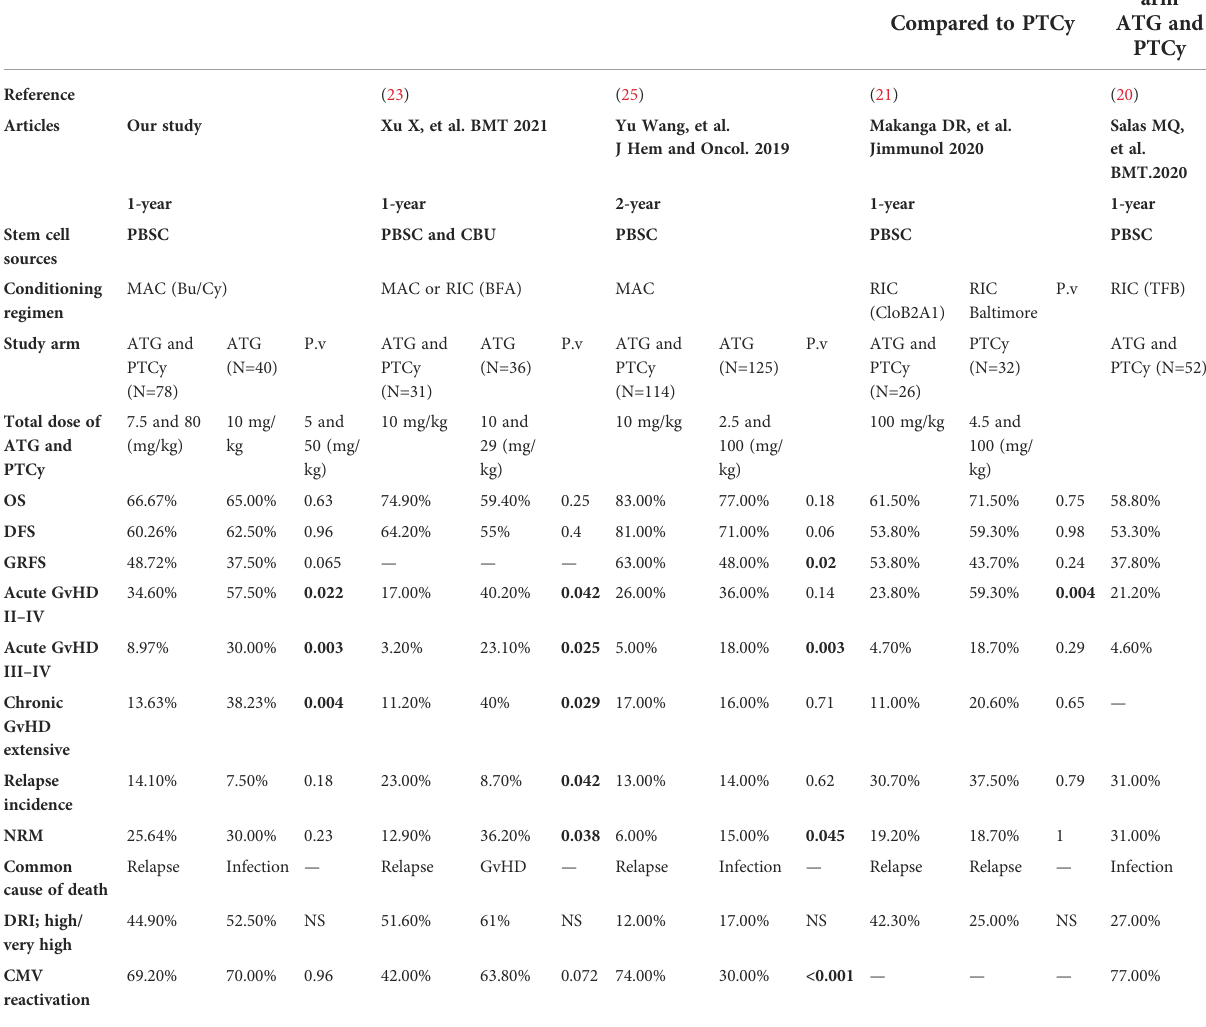
TABLE 4 Summary of previous publications that employed a combined (anti-thymocyte globulin and post-transplant cyclophosphamide) regimen for haploidentical peripheral blood stem cell transplantation. Study